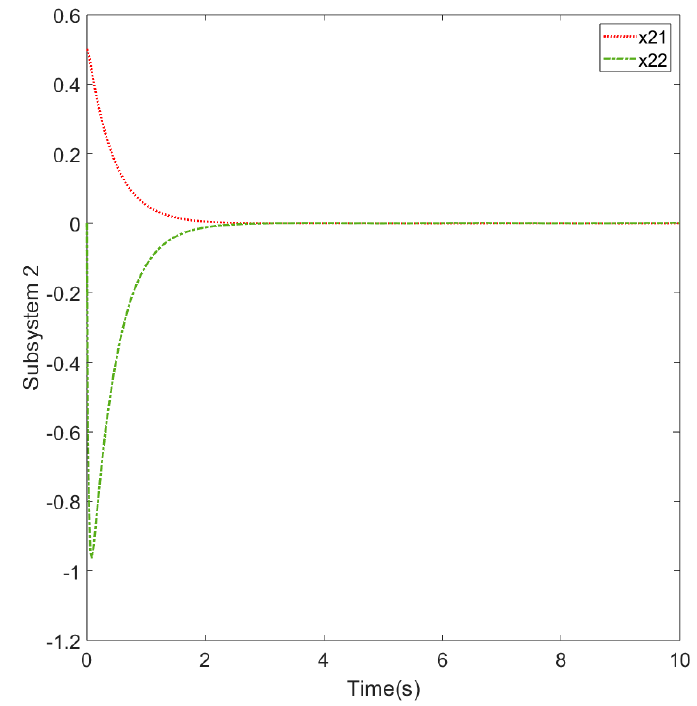
x for Example 2. Figure 10. Responses of x 2 for Example 2. 2